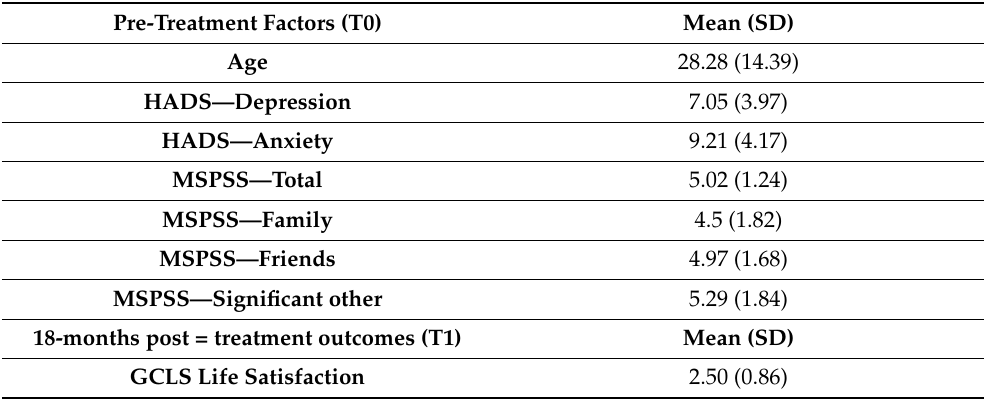
Table 1. Mean and SD for age, hospital anxiety and depression scale (HADS), multidimensional scale of perceived social support (MSPSS), and gender congruence and life satisfaction scale (GCLS) for all participants ( n = 134).